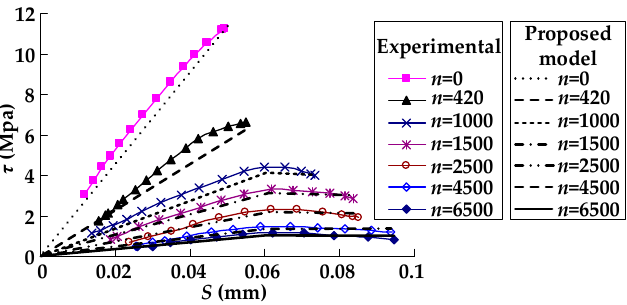
Figure 8. The comparison between the proposed model and the test results of specimen D-1.